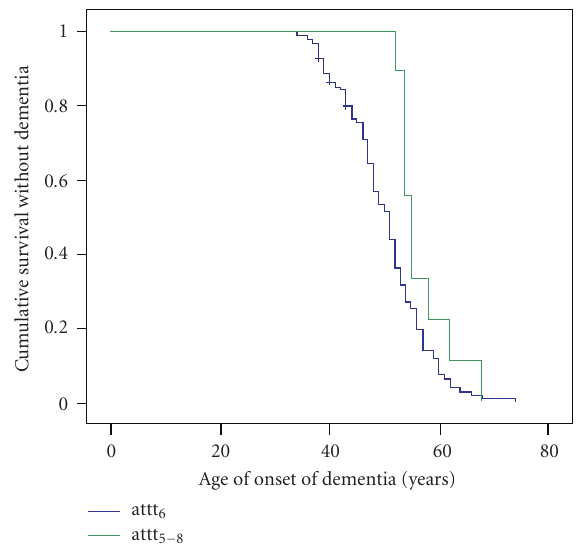
Figure 1: Kaplan-Meier survival plot showing the e ff ect of the tetranucleotide attt 5–8 upon age of onset of dementia in 103 people with DS. Those people carrying three copies of the attt 6 allele of this polymorphism develop dementia with an earlier age of onset than those with any other combination of alleles ( P = .